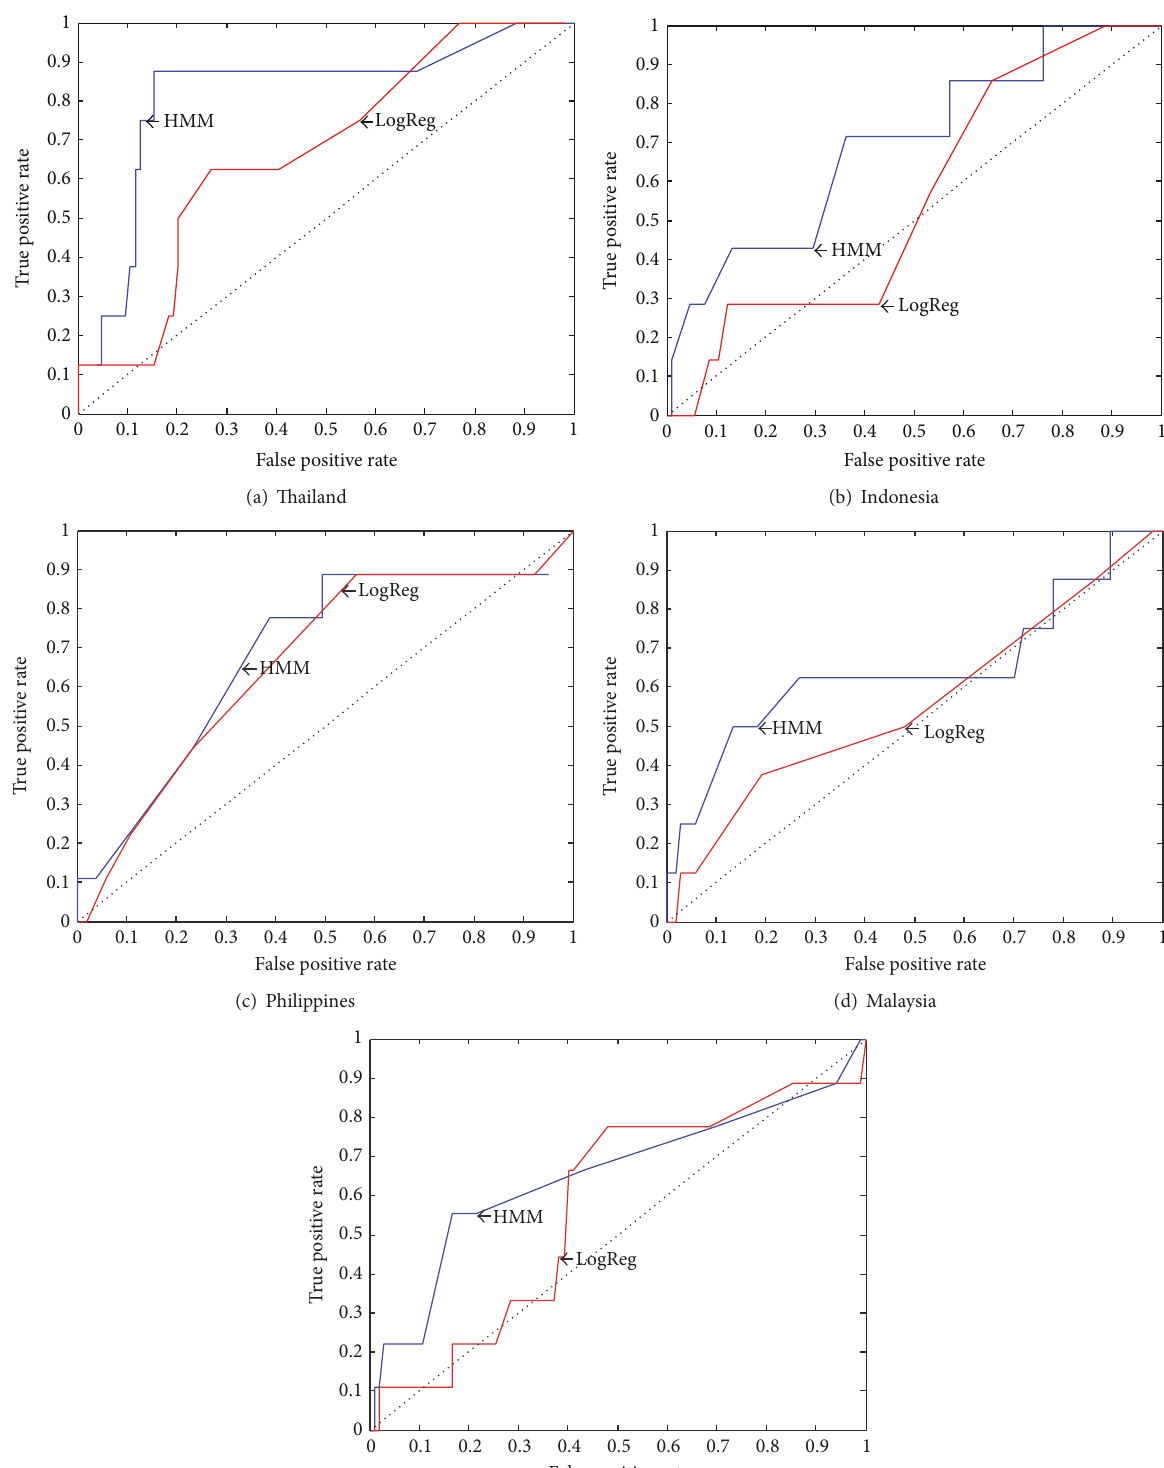
Figure 7: ROC curves for the compared prediction models. The HMM based social unrest event prediction model outperforms the LogReg model for each individual